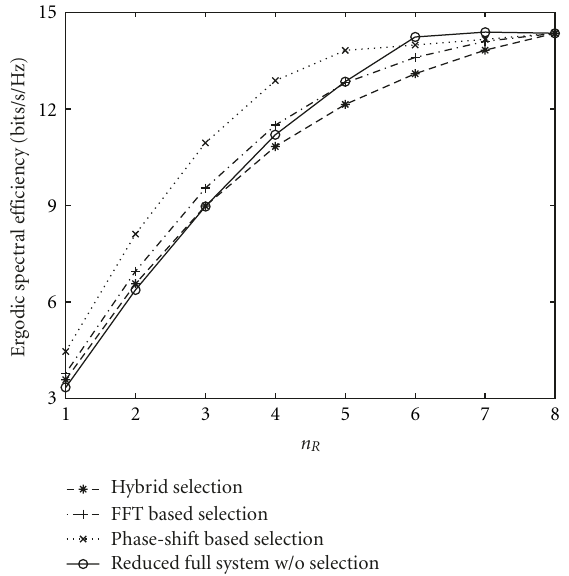
Figure 7: Ergodic spectral e ffi ciency of a compact MIMO system with AS, where M = 5 and N = 8.